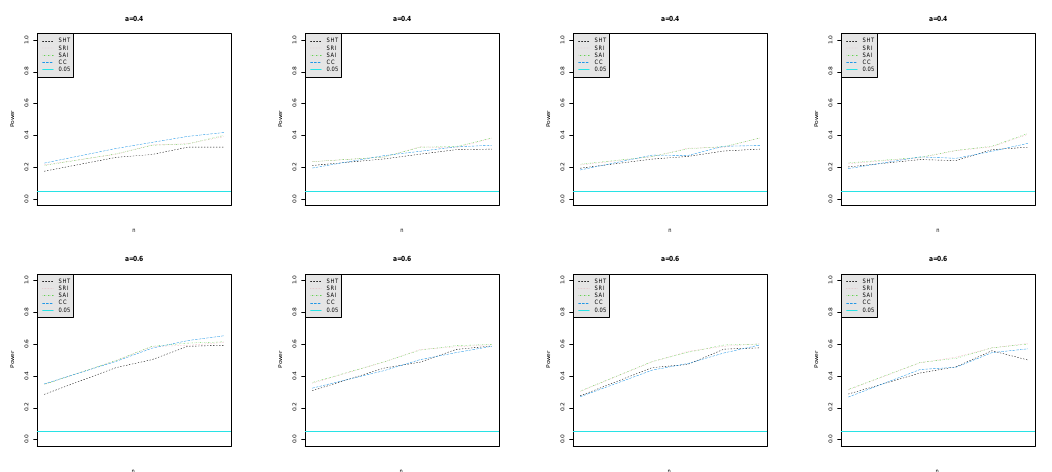
Figure A4. SHT, SRI, SAI and CC represent empirical powers evaluated from IPW, regression imputation, AIPW and CC methods against the sample size n for missingness data mechanism models E1 (left panel), E2 (left second panel), E3 (right second panel) and E4 (right panel) for a = 0.4 (upper row) and 0.6 (lower row) under unbalanced design ( n E : n R : n P = 2:1:1). Figure A5 presents empirical powers against treatment effect α E 1 for four missingness data mechanism models E1–E4 under balanced design. Figure A6 presents empirical powers against treatment effects α E 1 for four missingness data mechanism models E1–E4 under unbalanced design with n E : n R : n P = 2:1:1.